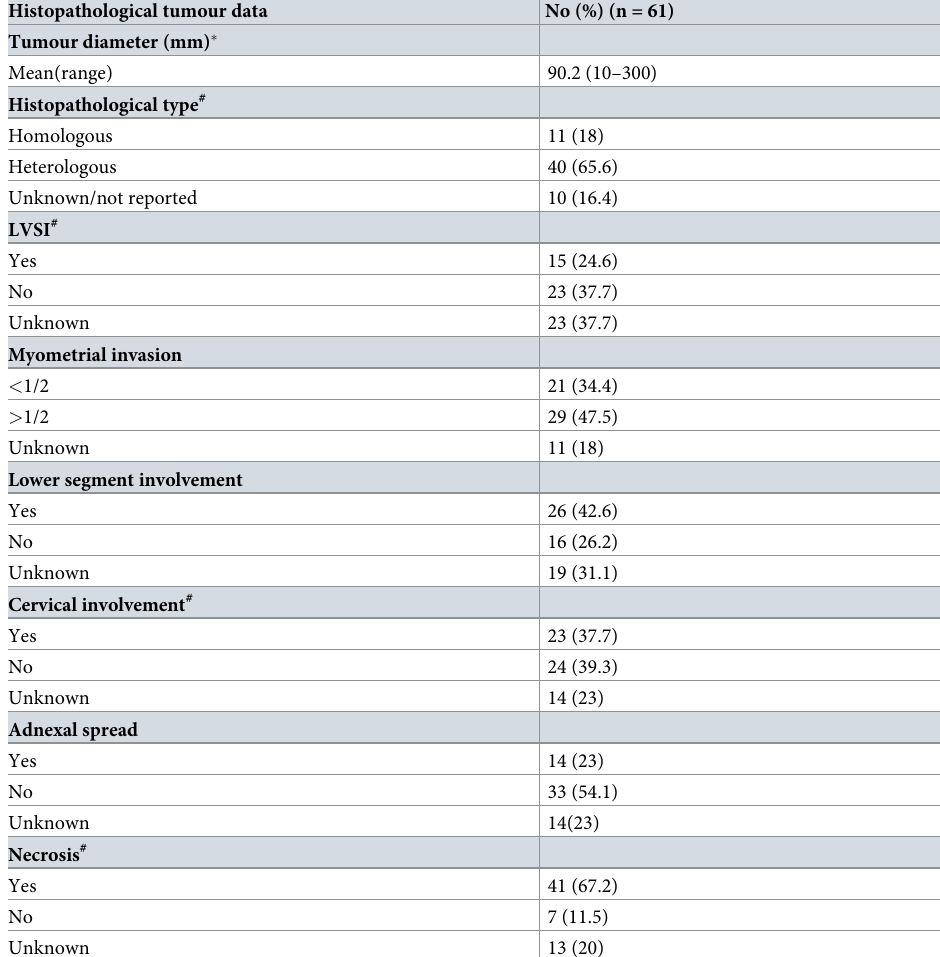
Table 3. Histopathological tumour